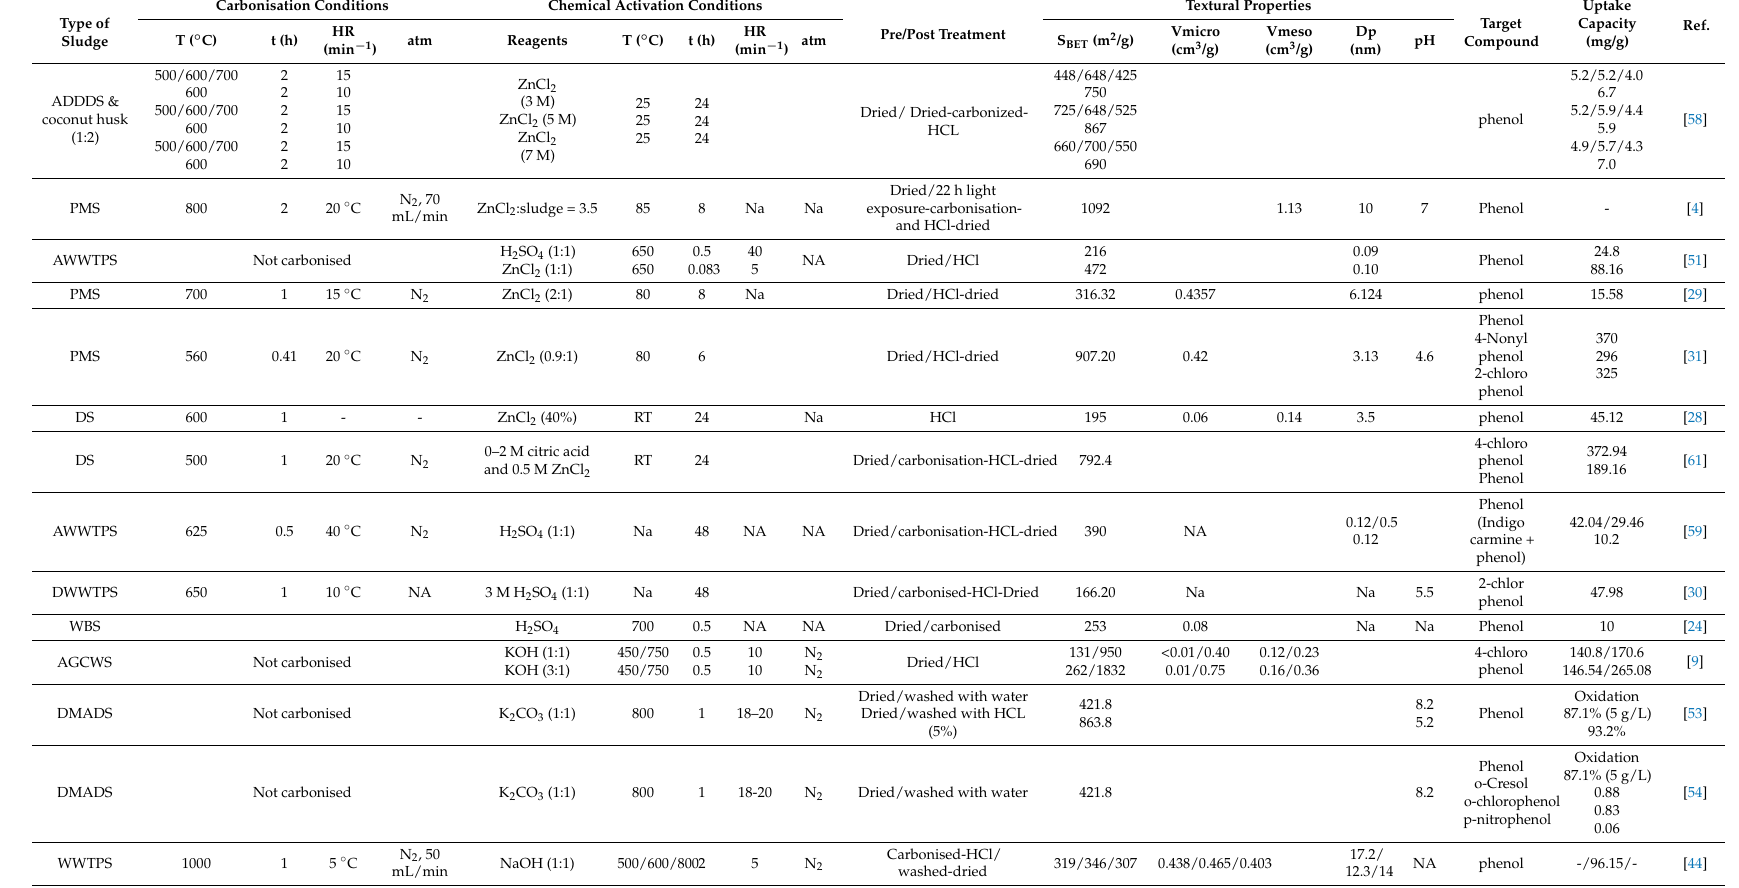
Table 4. Properties of SBAC produced from chemical treatment method for PC